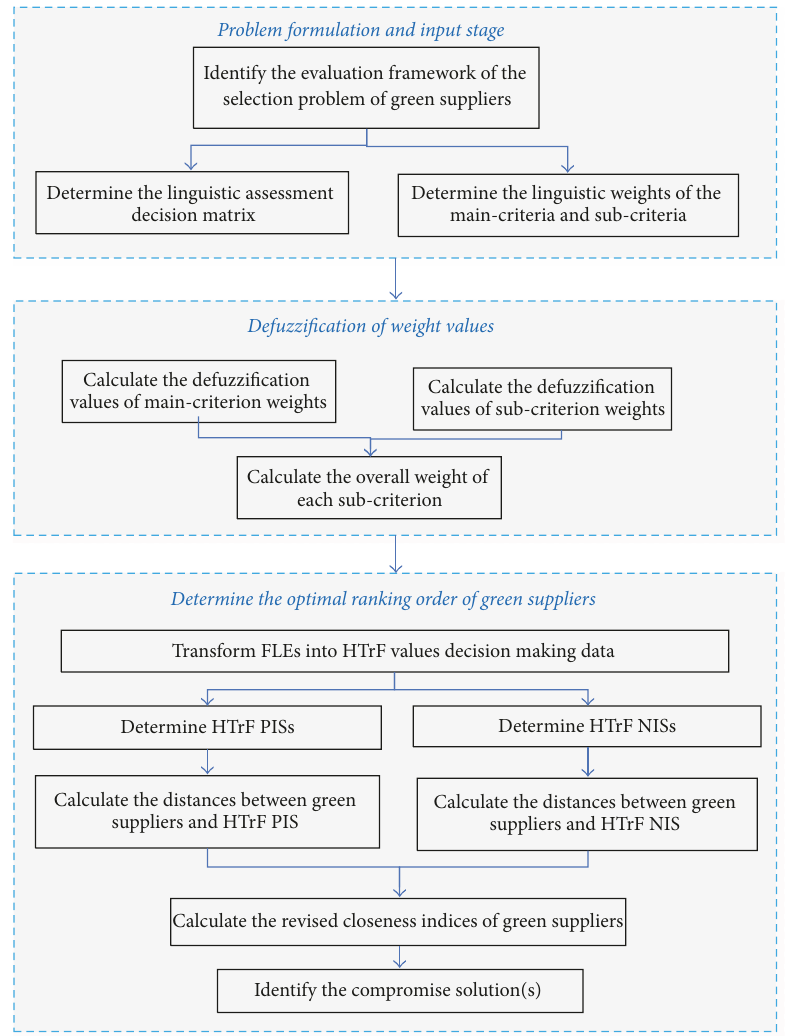
Figure 4: The diagram of the decision processes for the HTrF MCDM